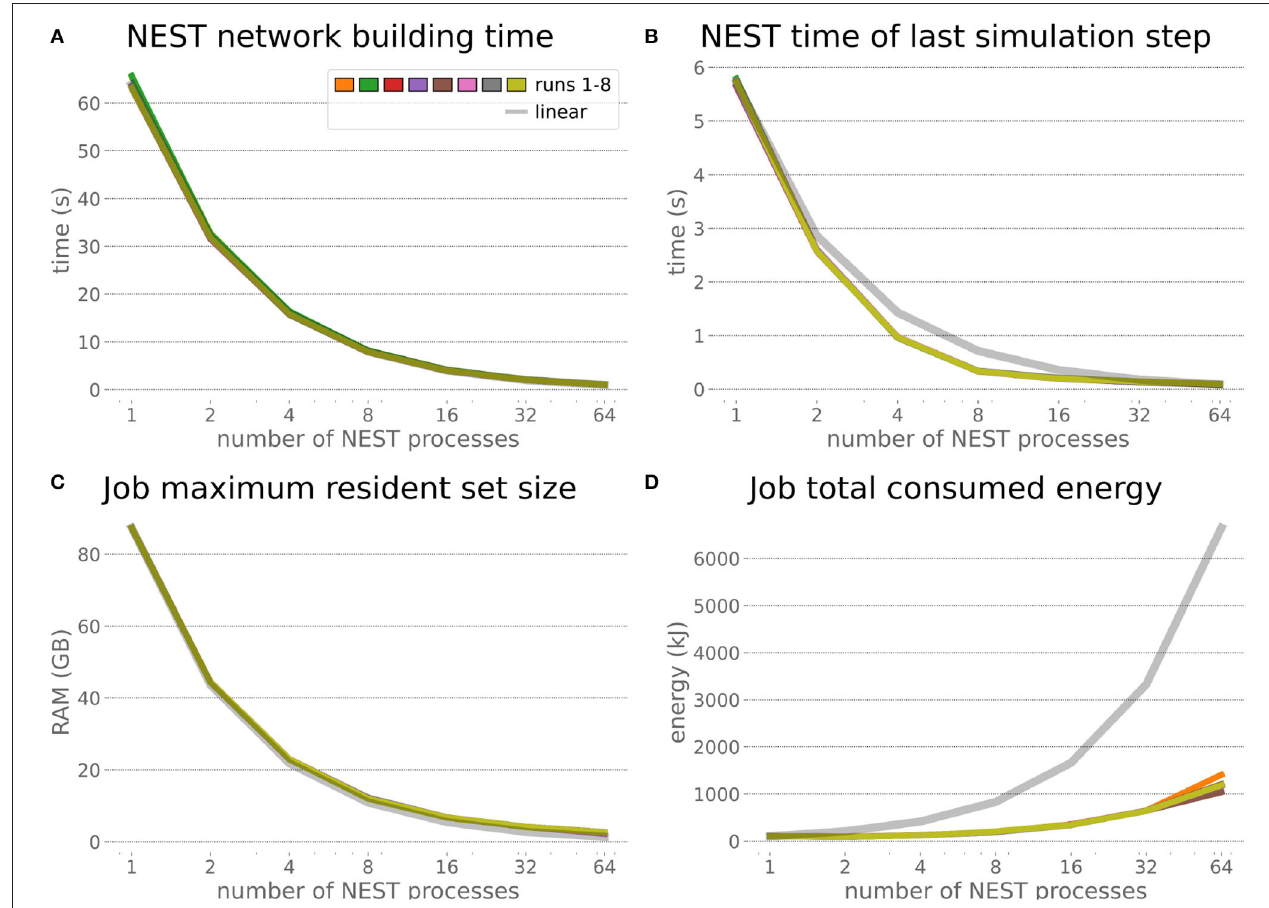
FIGURE 8 | HPC Benchmark NEST times and workload manager characteristics. (A) Network building time (i.e., creating and interconnecting nodes) scales nearly linearly. The time to simulate the last brain step (B) scales even supra-linearly with 2–32 NEST processes. Similarly, the required memory per compute node (C) reduces close to linear, but the total energy consumed (D) by all tasks is only 12 times more for 64 NEST processes compared to 1 process.